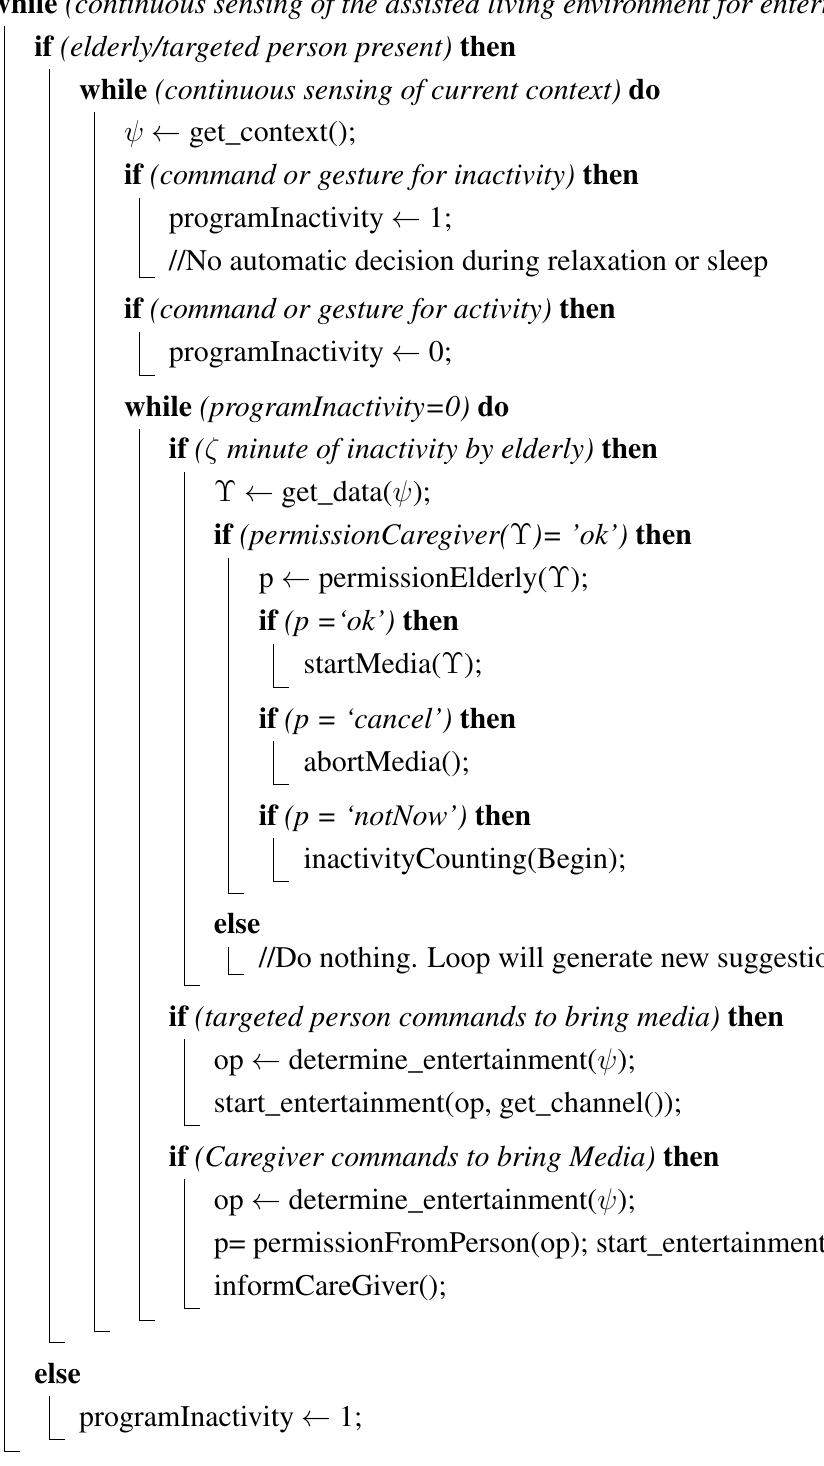
Algorithm 1: Activity